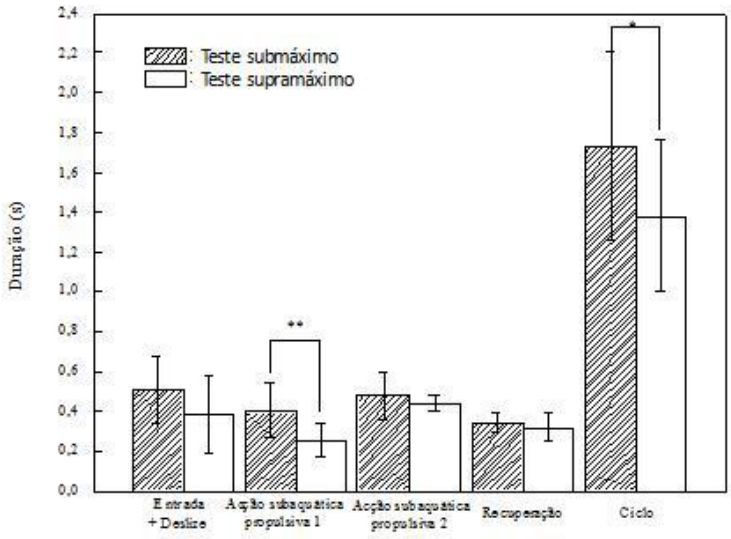
Figura 3. Média de desvio padrão da duração absoluta do ciclo e das fases do ciclo gestual durante os testes submáximo e máximo (*p<0,05; **p<0,01). Da análise da Figura 2, destacamos